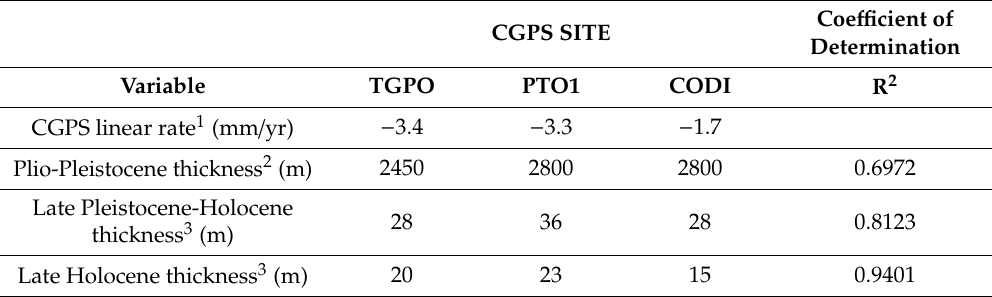
Table 3. Comparison between ground lowering rates and geological sequence